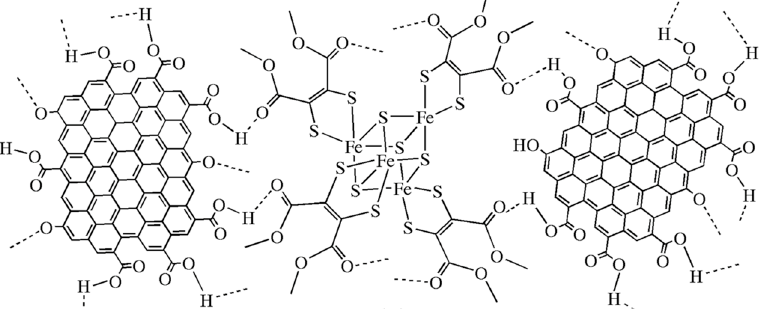
Figure 6. H-bonding interactions in [PPh 4 ] 2 [Fe 4 ( μ 3 -S) 4 (DMET) 4 ]@graphene. Reprinted with Figure6. H-bondinginteractionsin[PPh 4 ] 2 [Fe 4 ( µ 3 -S) 4 (DMET) 4 ]@graphene. Reprintedwithpermission permission from reference [76] . from reference